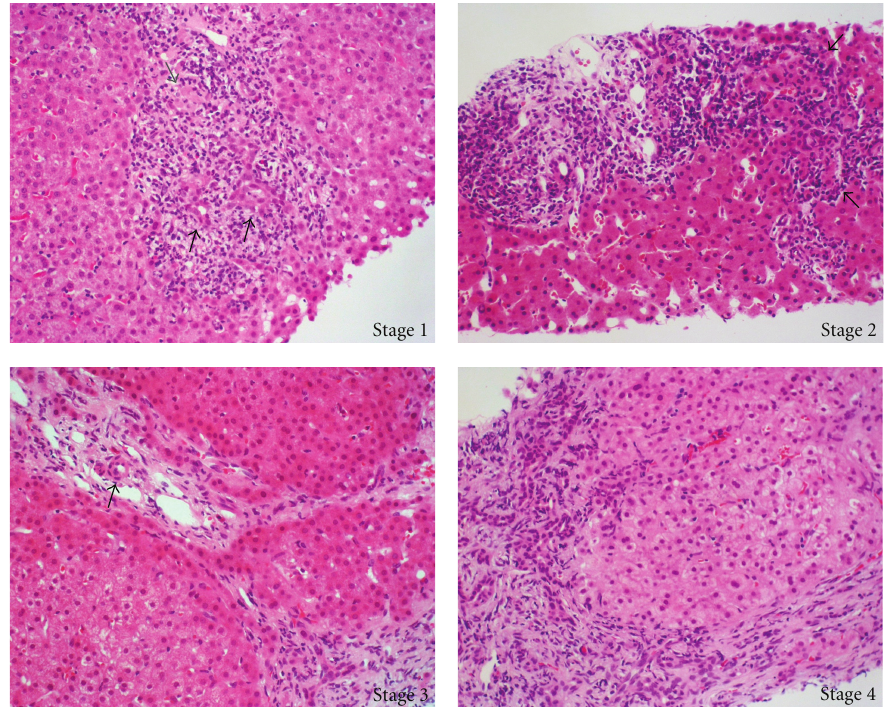
Figure 1: Histological staging in a representative case of a patient with primary biliary. Stage 1 reveals duct-centred inflammation showing chronic nonsuppurative destructive cholangitis (black arrows). A tiny granuloma is also seen (grey arrow). Stage 2 shows portal enlargement (arrows) with bile ductular reaction and inflammatory cell infiltration. Stage 3 is characterized by fibrous scaring bridging portal tracts with occasional foci of bile duct loss (no bile duct identified around an artery indicated by arrow). Stage 4 shows cirrhotic